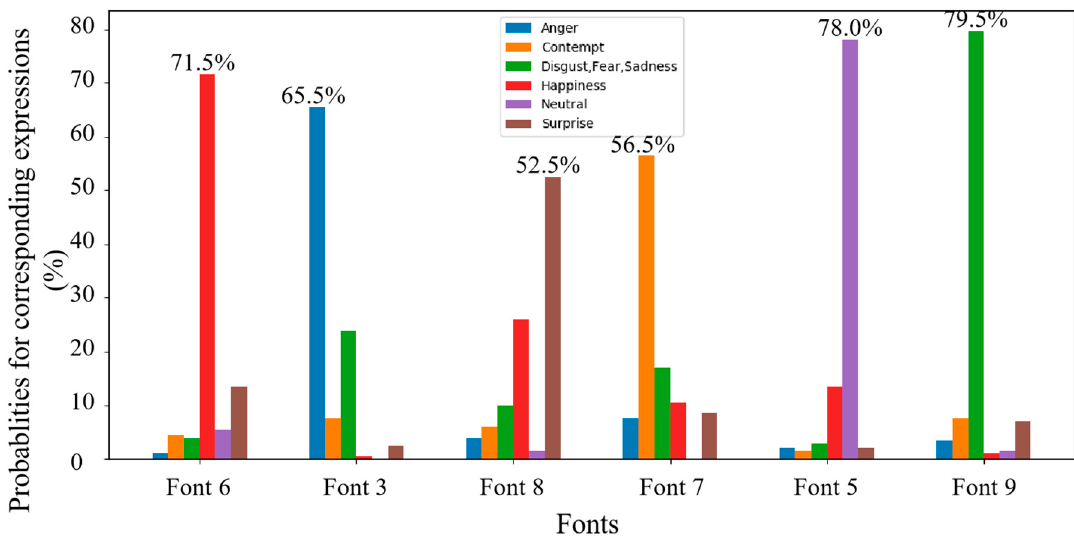
Figure 13. Evaluation results of fonts generated by our proposed model.